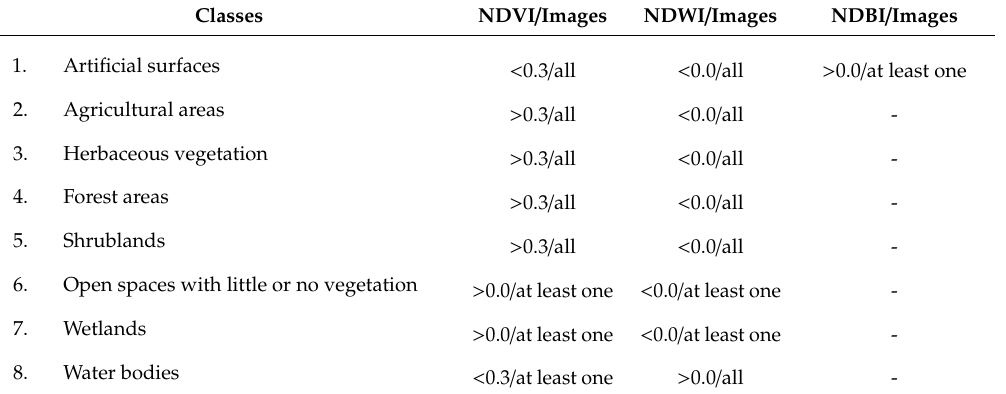
Table 6. Condition used for filtering the TD1 dataset with the NDVI, NDWI and NDBI indices, to obtain